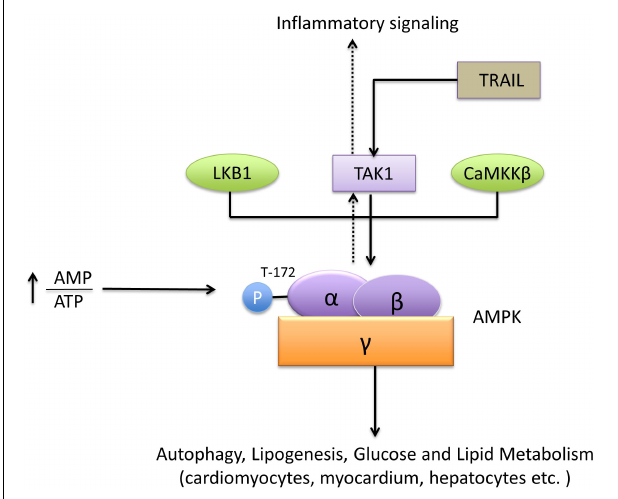
FIGURE 4 | TAK1 and AMPK signaling. AMPK is a heterotrimeric protein formed by the subunits α , β , and γ . The recognized upstream proteins of AMPK include LKB1, CaMKK β , and TAK1. TAK1 mediates the phosphorylation of AMPK at T172 and promotes its activation. The downstream pathways, including autophagy, lipogenesis, glucose, and lipid metabolism, are subsequently activated by